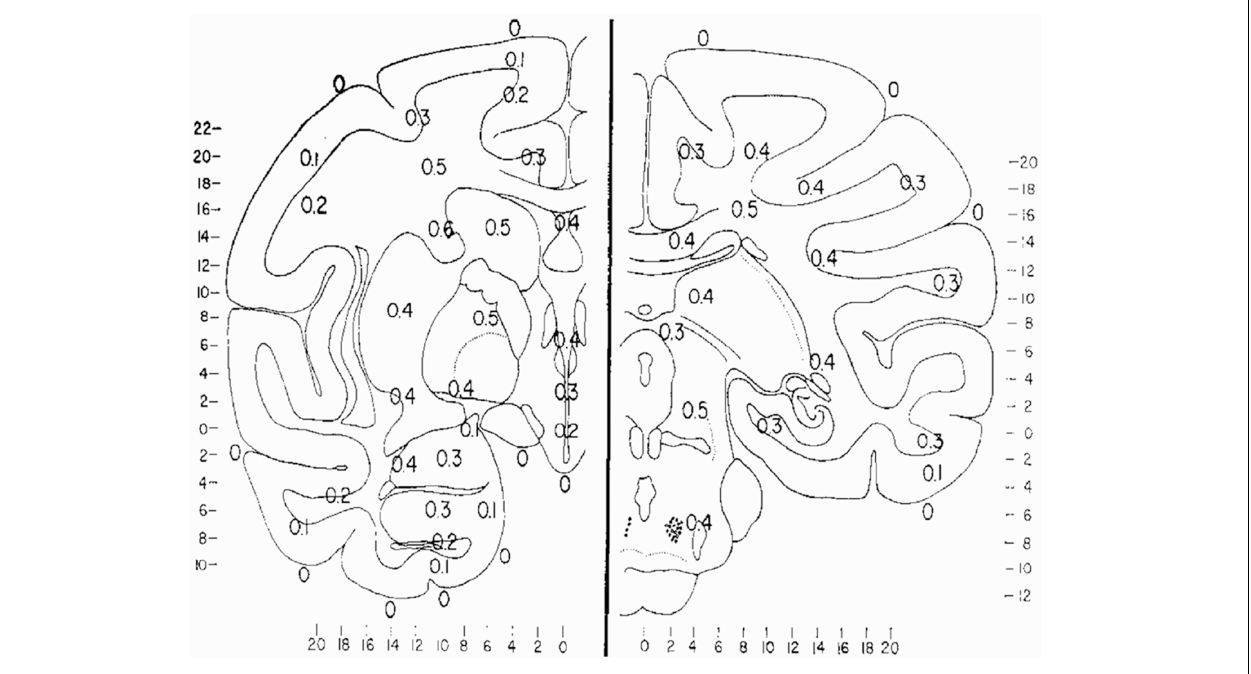
FIGURE 1 | Thermal map of the brain. The results of measurements of the temperature difference between arterial blood and 100 brain and subarachnoid sites in 16 monkeys during 347 experiments. Values expressed are T i –T a temperature of intracranial site minus the temperature of the aortic arterial blood measured simultaneously, and are